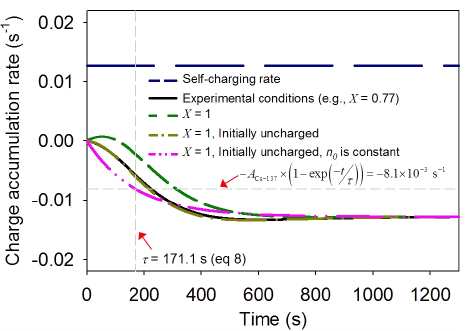
Figure 7. Validation of the numerical solution for the bivariate population balance model under a monodispersed initial condi- = 10 18 m − 3 ) . The tion ( d p = 0 . 003µm, N t = 10 15 m − 3 , and n 0 ion lines and symbols represent the results of the analytical solution of Alonso (1999) and Eq. (11),